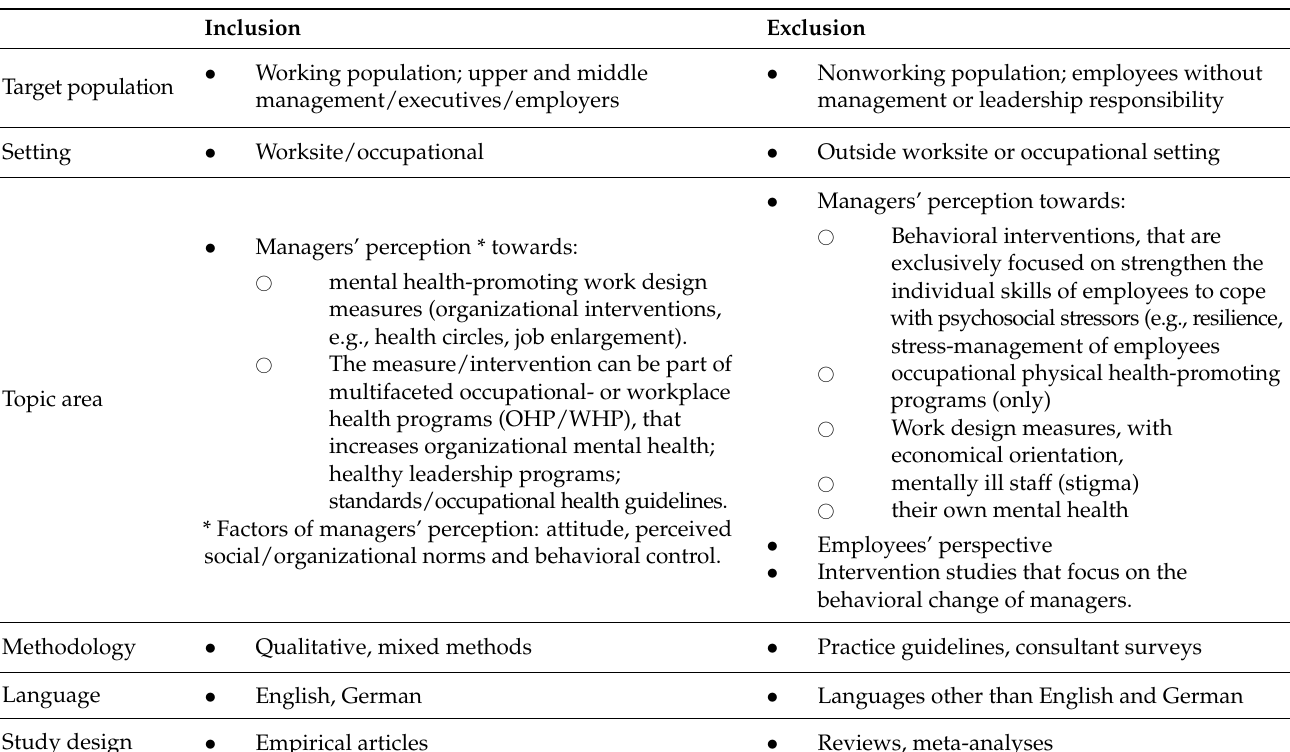
Table A2. Inclusion and exclusion criteria used for study